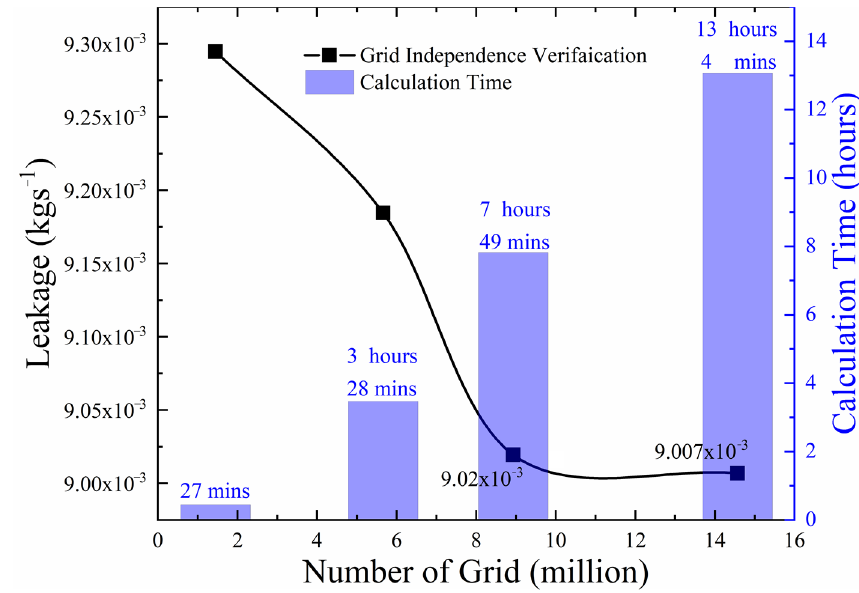
Figure 7. Leakage performance of different elements meshing.